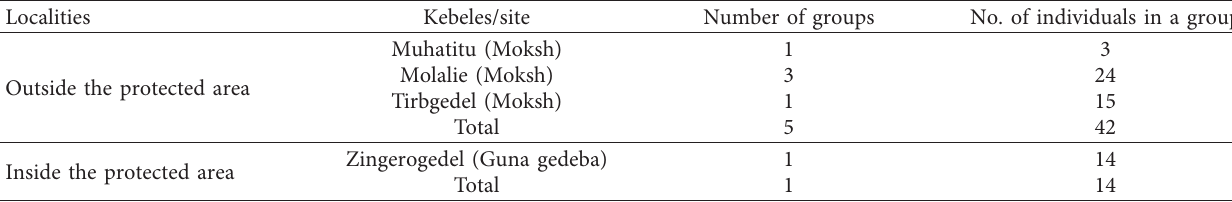
Table 3: Site, kebele, and total group number of Geladas in Mt. Guna.